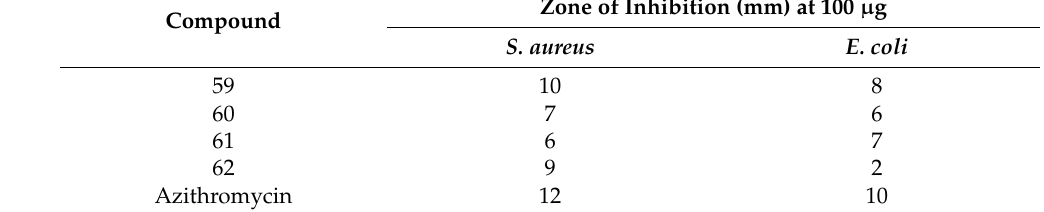
Table 3. Antibacterial activity of quinoxaline-based substituted benzene sulfonamide derivatives. Compound